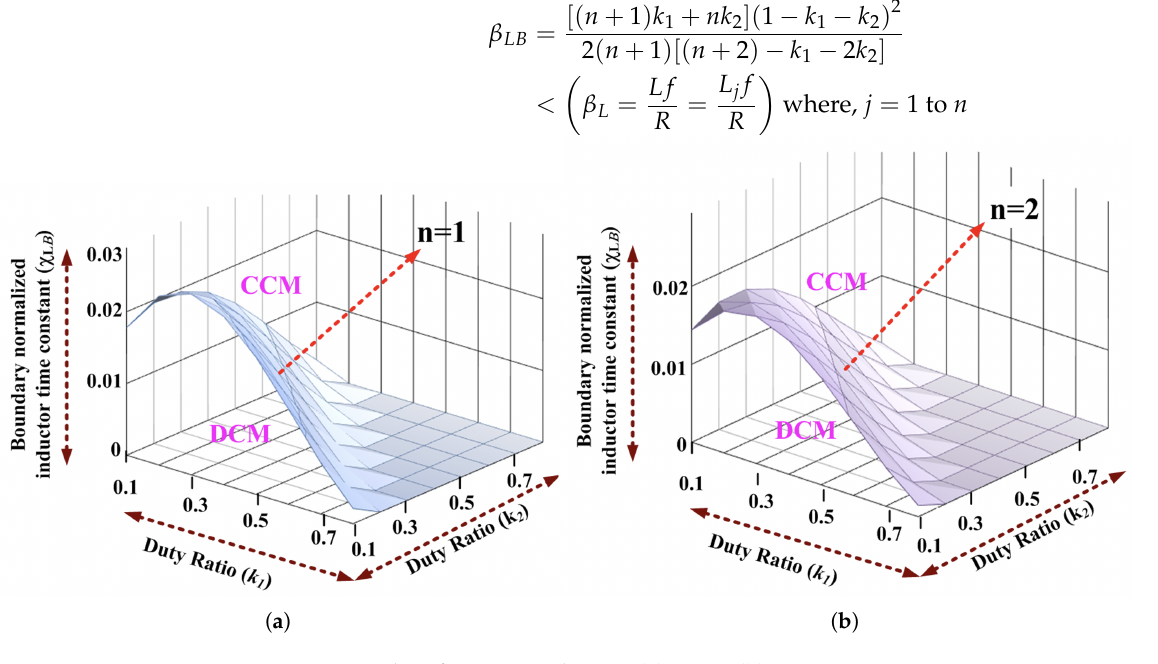
Figure 7. Boundary for CCM and DCM, ( a ) n = 1, ( b ) n =